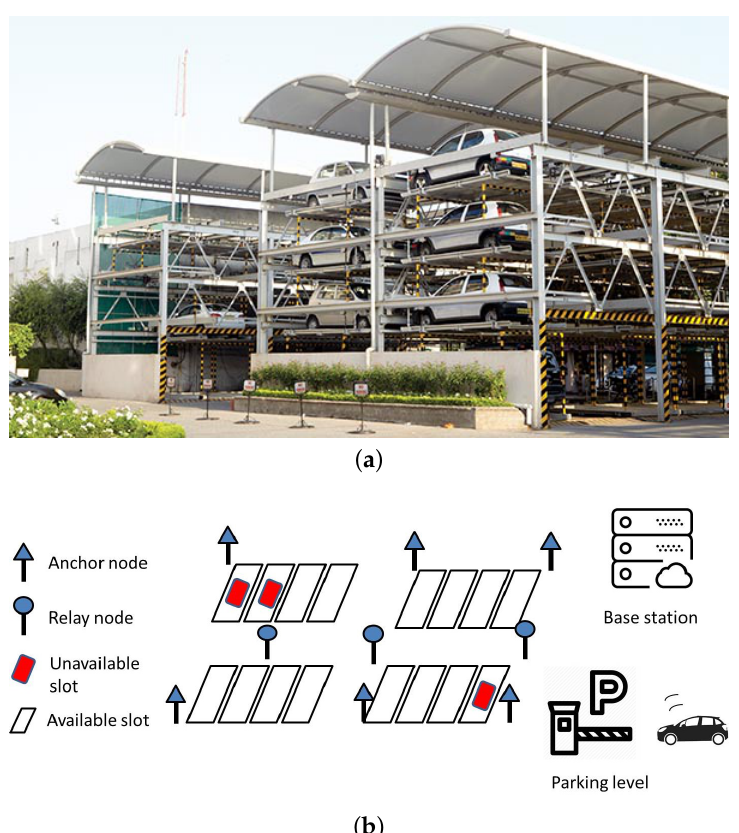
Figure 2. Example of an intelligent vehicle parking system. ( a ) A typical multi-level parking site [24]; ( b ) Infrastructure at a single